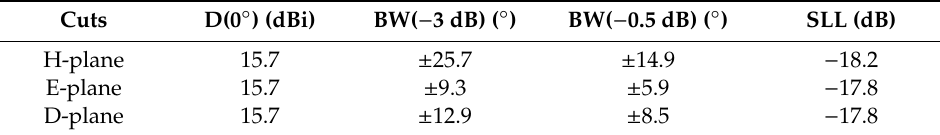
Table 2. Embedded radiation pattern characteristics of the 11 × 5 array.